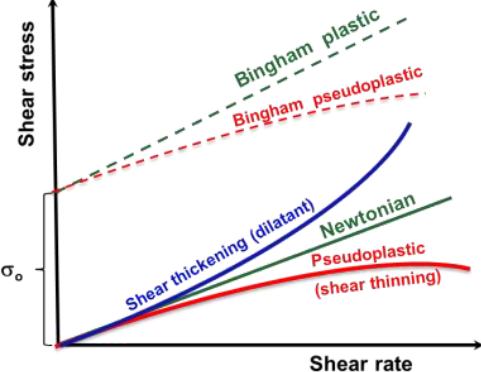
Figure 3. Schematic presentation of flow curves for various types of fluids.